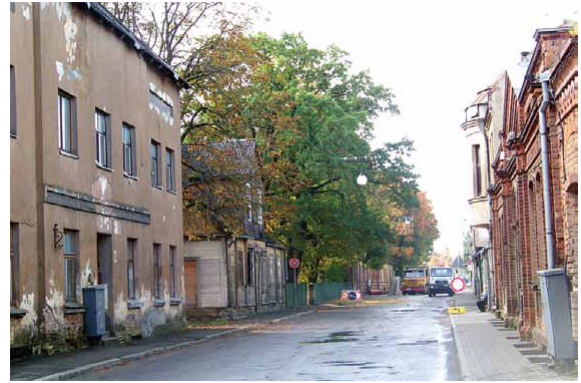
Fig. 5. Instead of the lost wooden buildings in riga street, there are breaking in huge tree branches hiding buildings of the historical urban environment which disrupts its scale. Source: author’s photo,